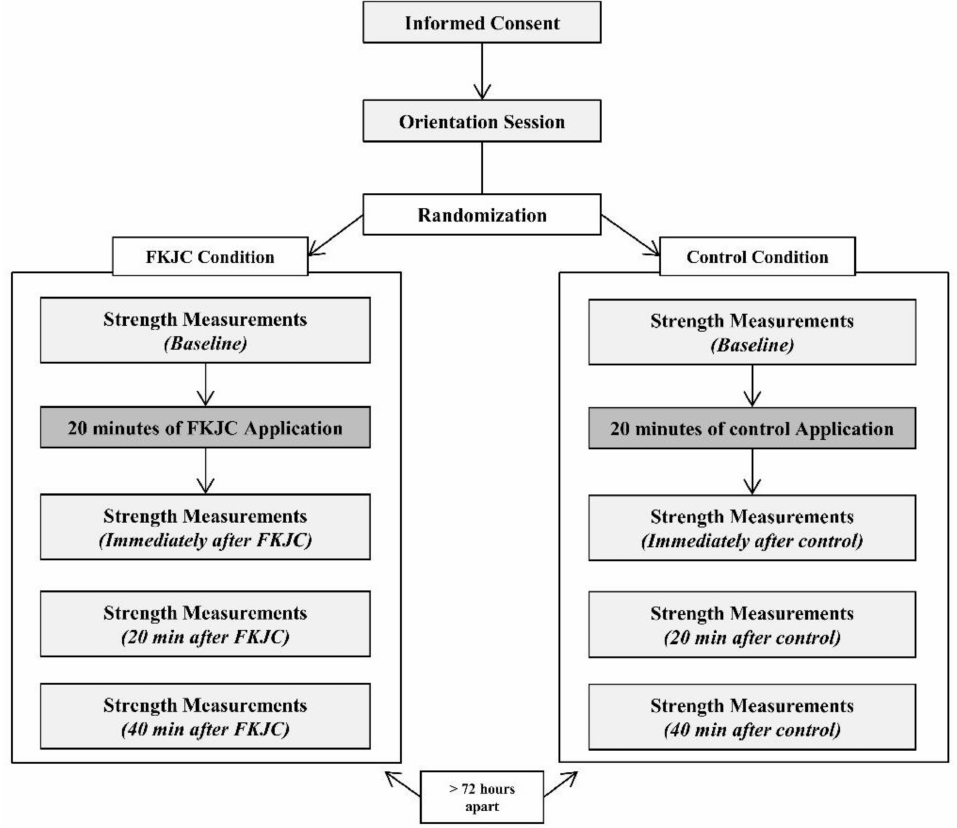
Figure 1. Flow chart of testing